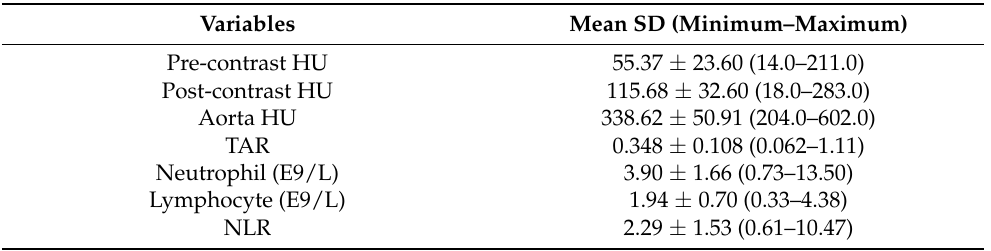
Table 2. Basic characteristics of Hounsfield units on computed tomography and serum neutrophil and lymphocyte